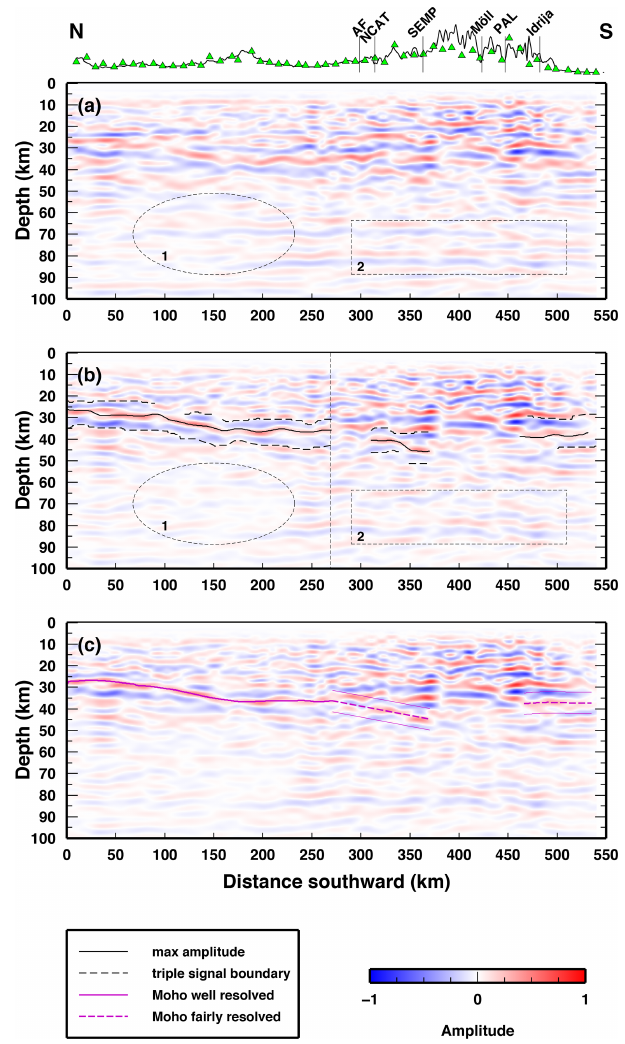
Figure 4. Reflectivity images of the crust and upper mantle along EASI; in the background the interpolated figure (bilinear interpola- tion), in which blue–red–blue triplet marks the presence of a pos- itive interface (i.e. an increasing impedance contrast with depth). (a) Depth-migrated GloPSI image generated by using 27 events. (b) Depth-migrated GloPSI image generated by using 64 events. The black solid line marks the maximum amplitude within the blue– red–blue triplet; the black dashed line marks the upper and lower boundary of the triplet; features 1 and 2 are described in the text. (c) Background same as (b) ; solid and dashed purple lines show the picked Moho depths reported in Table